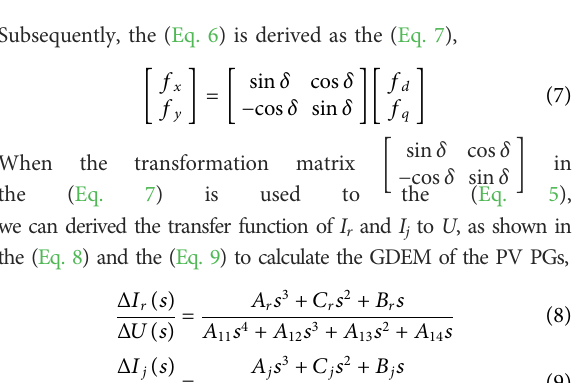
FIGURE 4 PV PGs integrated into IEEE 14 node topology.